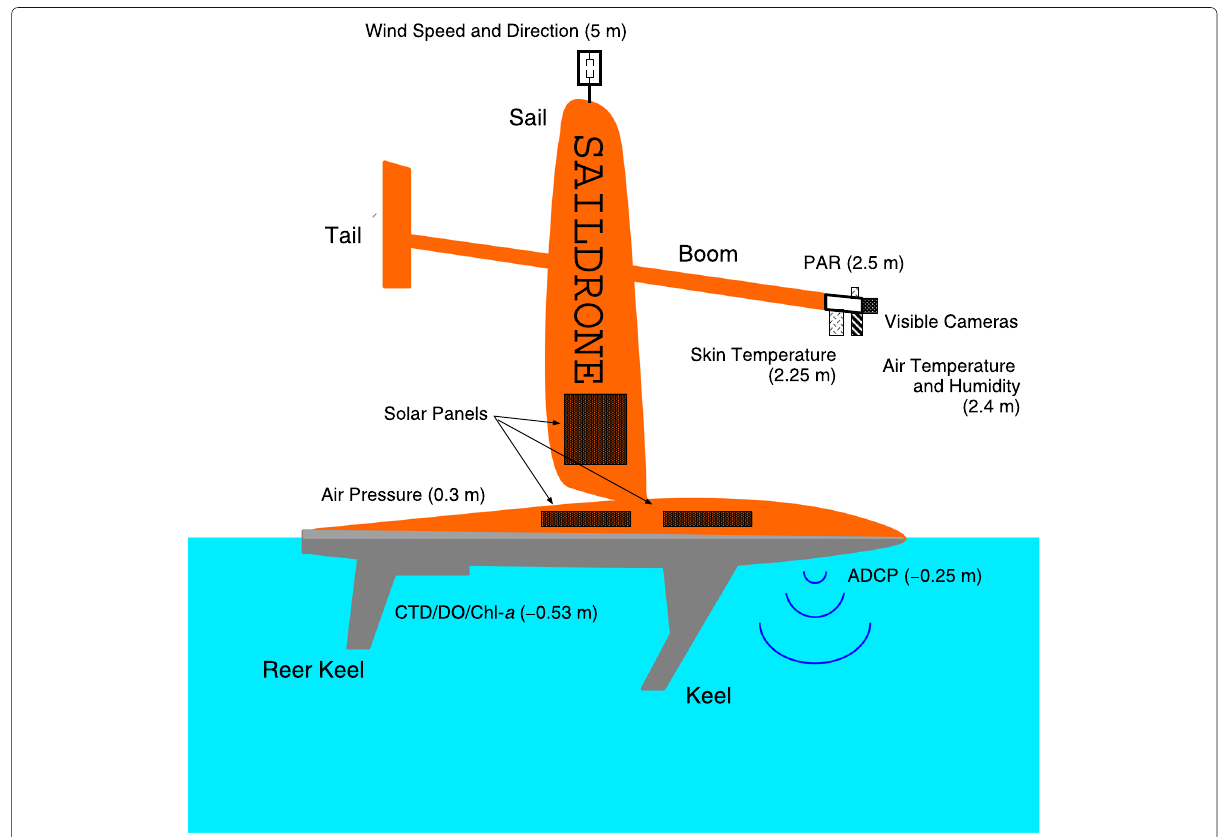
Fig. 2 Diagram of Saildrone Generation 5. The positive and negative numbers in parentheses indicate the heights of meteorological sensors and depths of oceanic sensors, respectively